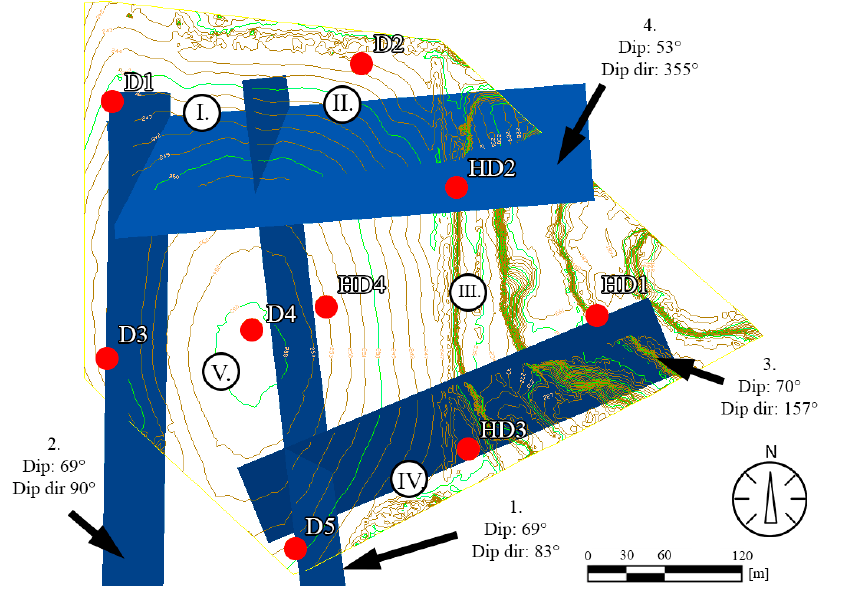
Figure 15. Major identified fault planes dissecting the contour lines (major faults are numbered 1–4) as seen from W. Blocks bordered by major faults and used for reserve calculations are numbered by I–V.